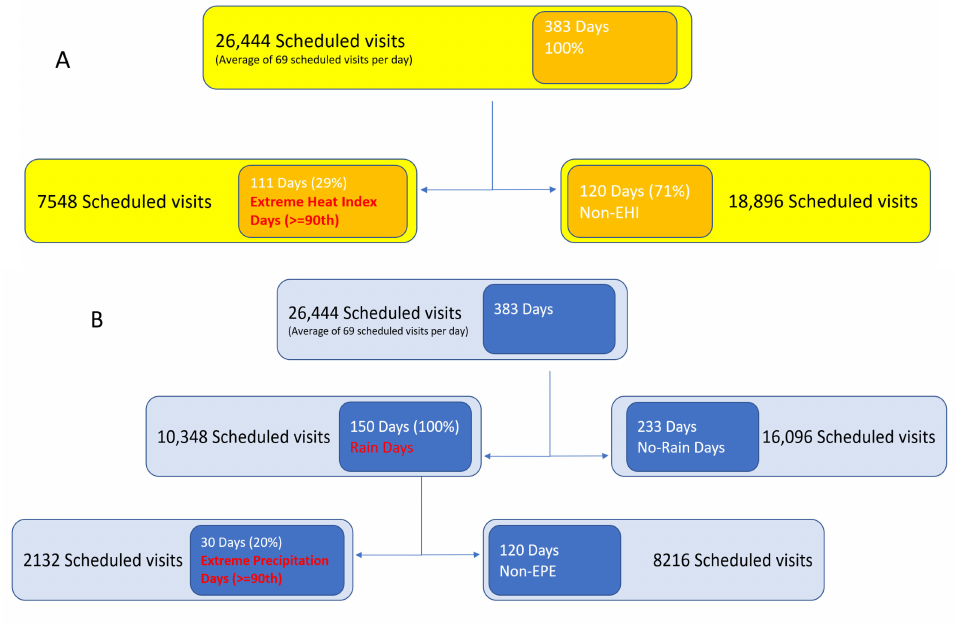
Figure 3. Weather and extreme weather events during study period. ( A ): Number of days with and without an extreme heat index in the study period. ( B ): Number of days with and without extreme precipitation in the study